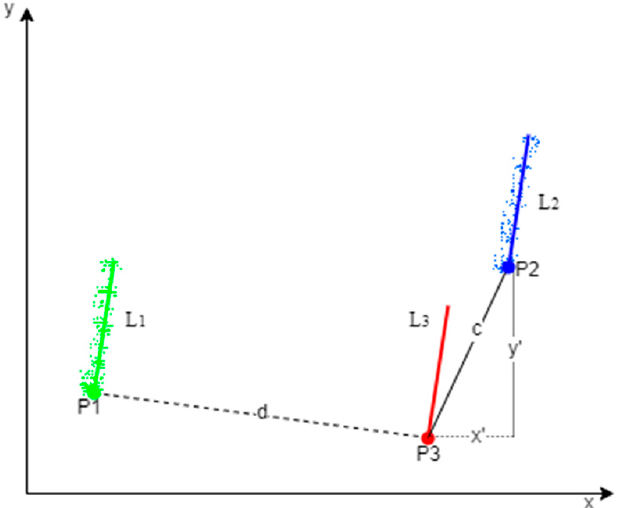
Figure 8. Schematic diagram of 2D displacement vector calculation for fine displacement of a pair of opposing facades of a building as an example.